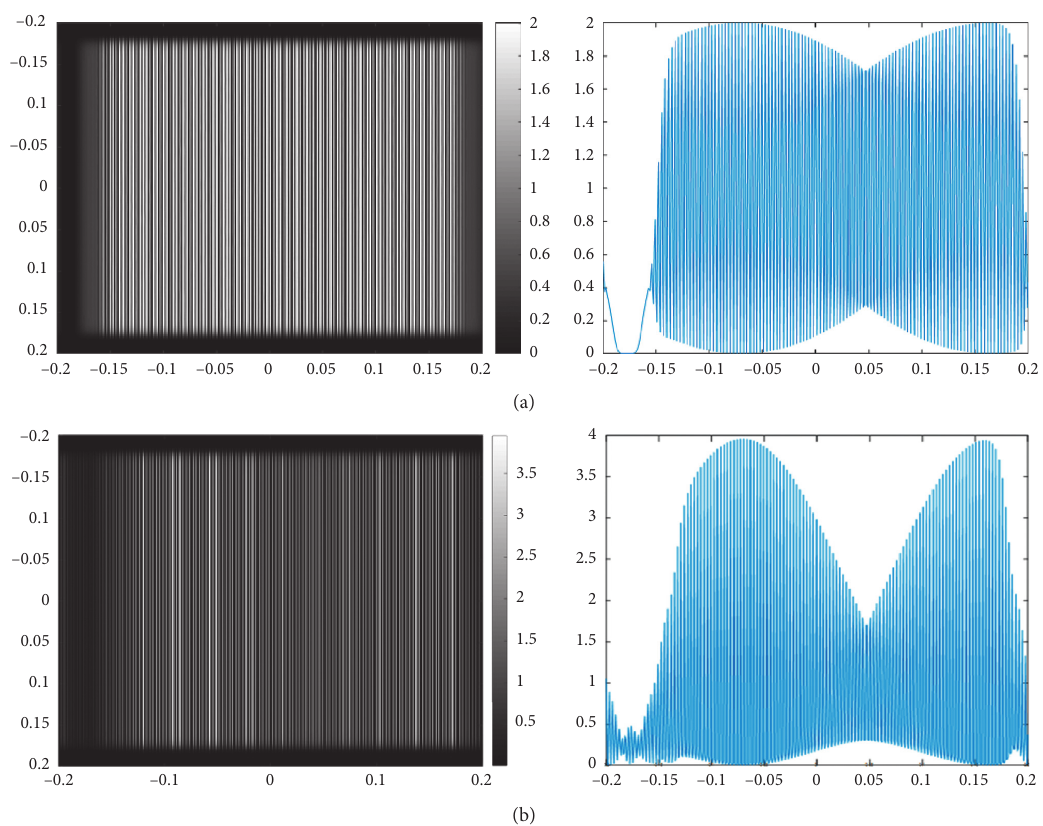
Figure 3: The calculating result of the optical characteristics of stray light shows (a) the superposition of stray light from two reflectors and (b) the superposition of stray light from four reflectors. Stray light from multiple reflectors will produce interference modulation, and the maximum order of interference modulation is 4 times. Therefore, the fluence of stray light in the analysis and control design, the modulation factor, should be multiplied by its intensity. The maximum fluence estimation can be multiplied by the maximum modulation factor 4.